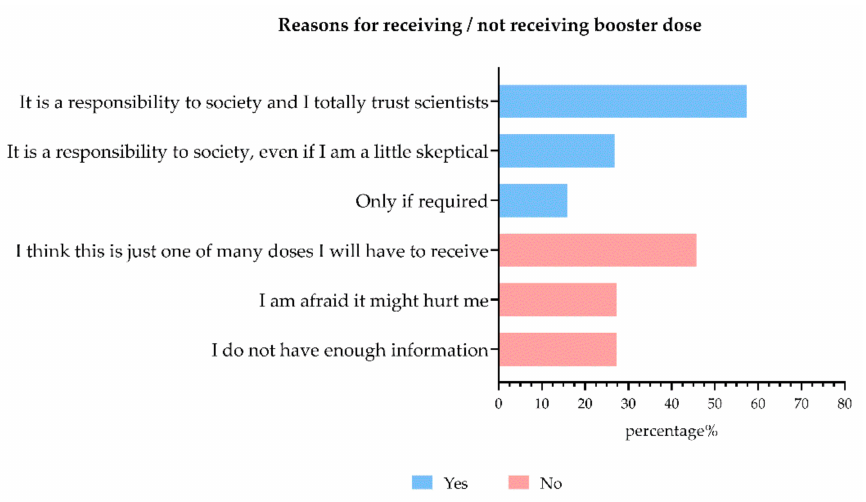
Figure 2. Reasons for not receiving a vaccine against COVID-19 reported by unvaccinated participants (n =